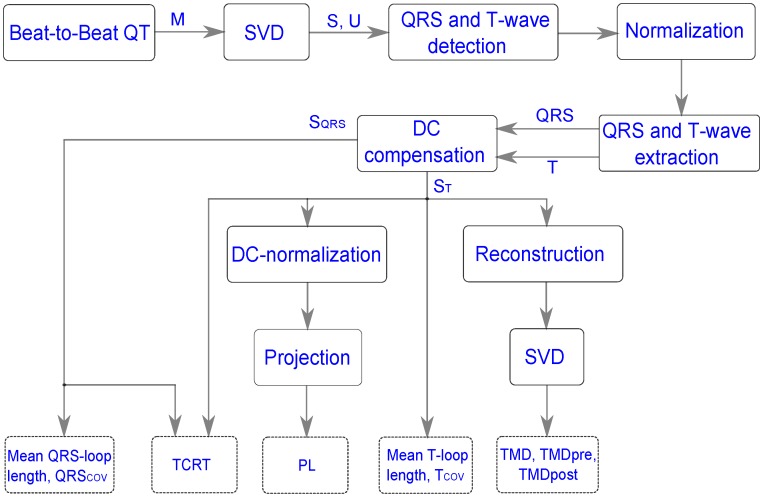
Block diagram of the overall beat-to-beat VCG approach.The solid line of rectangular or square represents the different processes or methods. The rectangles with dashed lines (at the bottom) represent the output parameters (descriptors).